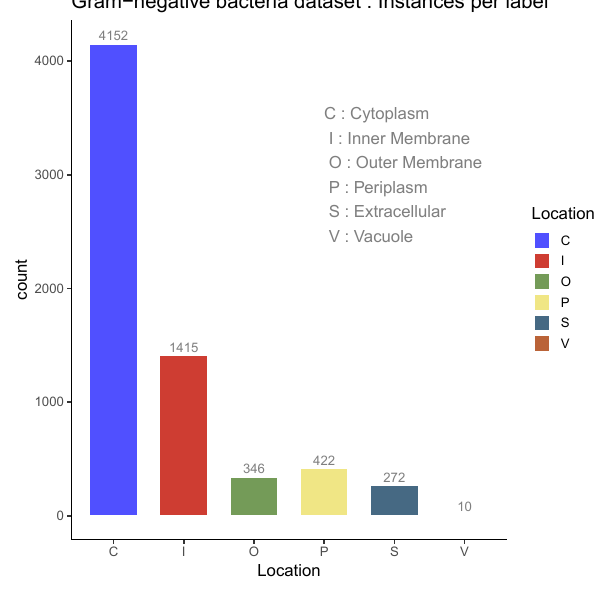
Figure 2: Gram-negative bacteria